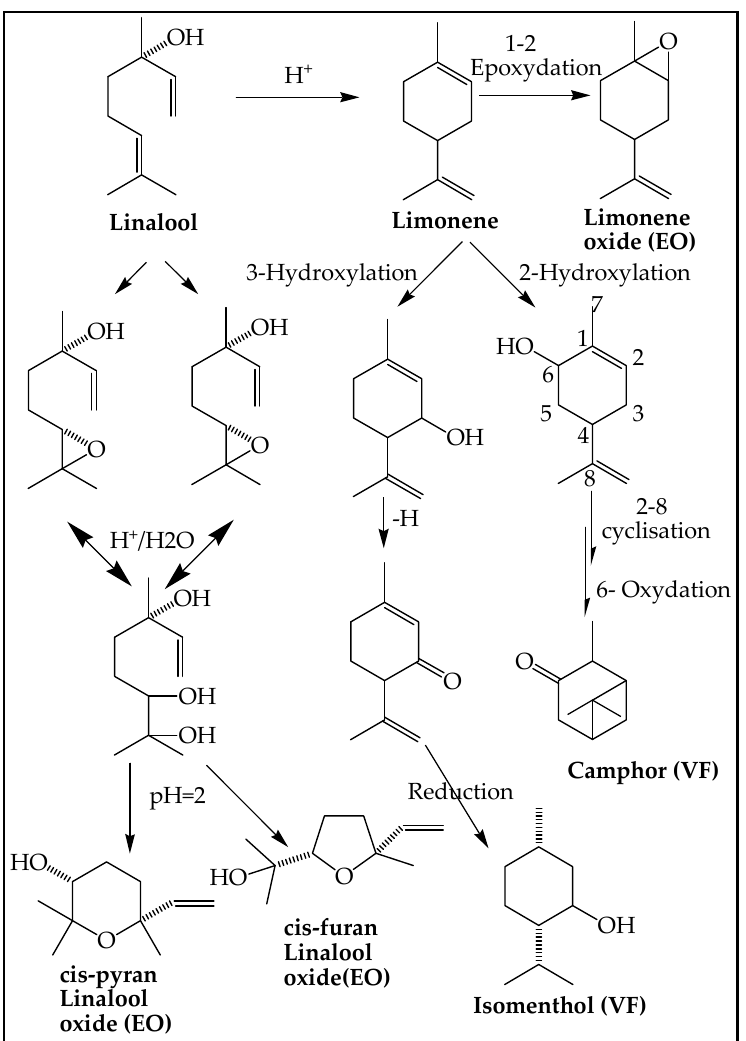
Figure 4. Bioconversion pathways of limonene and linalool using Aspergillus niger and proposed pathways (PPs) leading towards camphor and isomenthol.